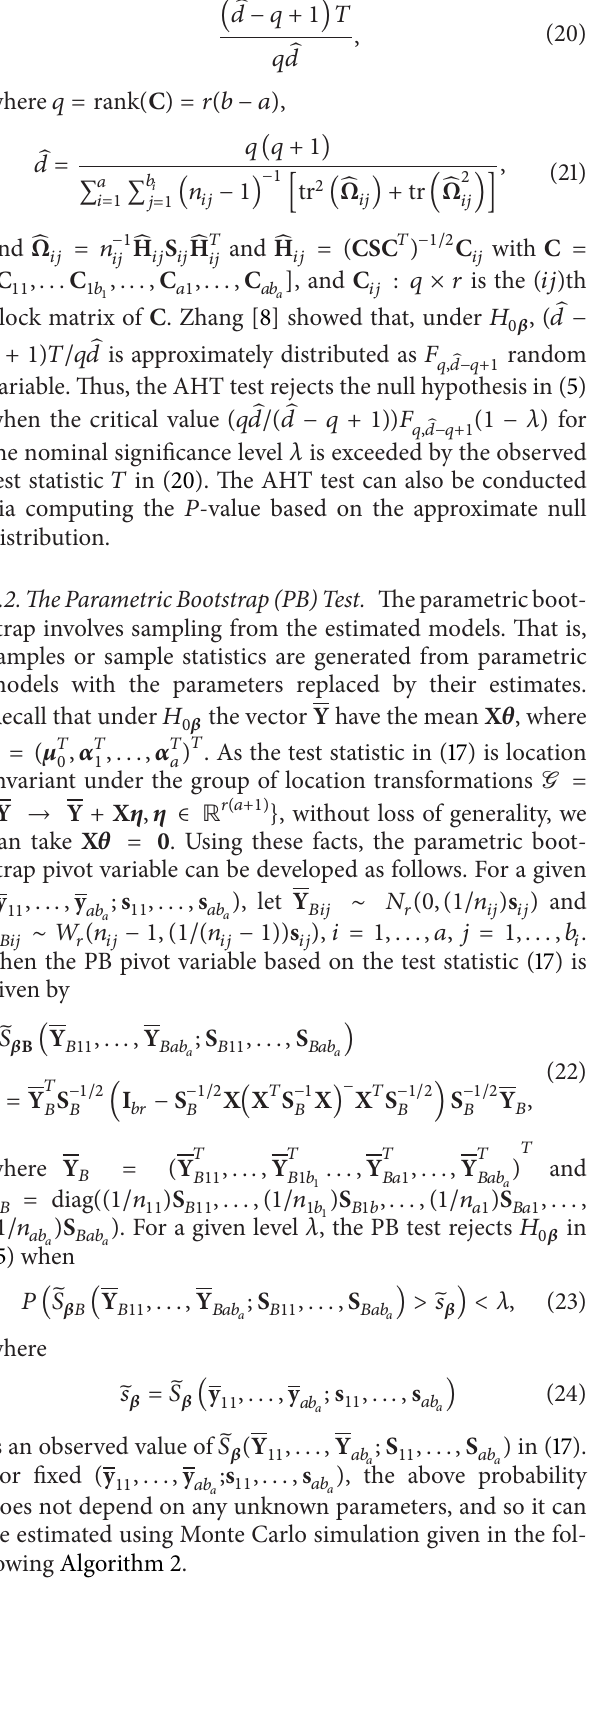
Algorithm 2. For a given (𝑛 11 , . . . , 𝑛 𝑎𝑏 , . . . , s ) ( s 11 𝑎𝑏 𝑎